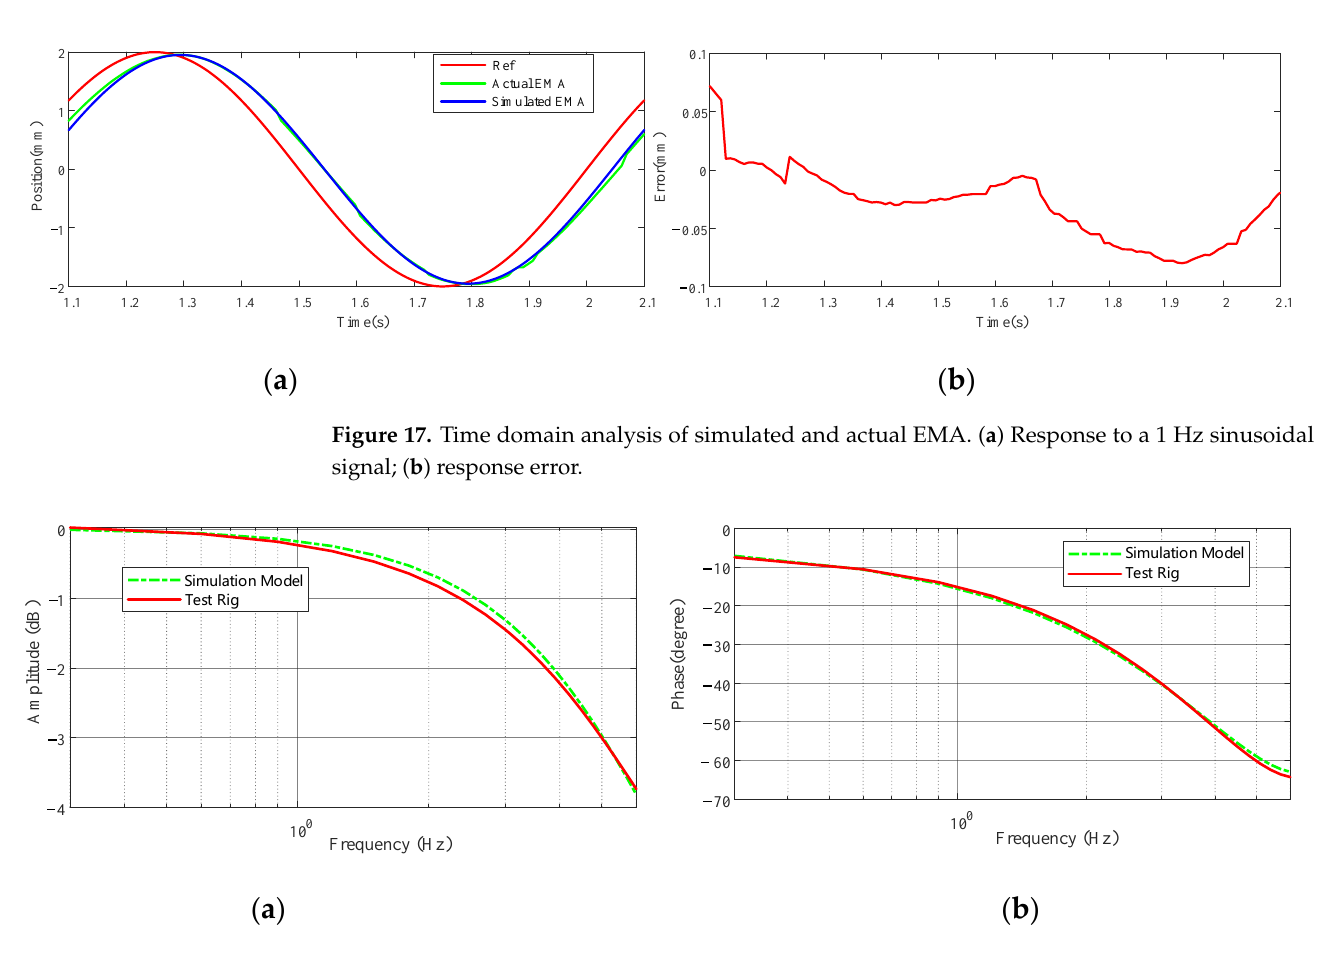
Figure 18. Frequency domain analysis of simulated and actual EMA. ( a ) Amplitude margin; ( b ) phase margin.